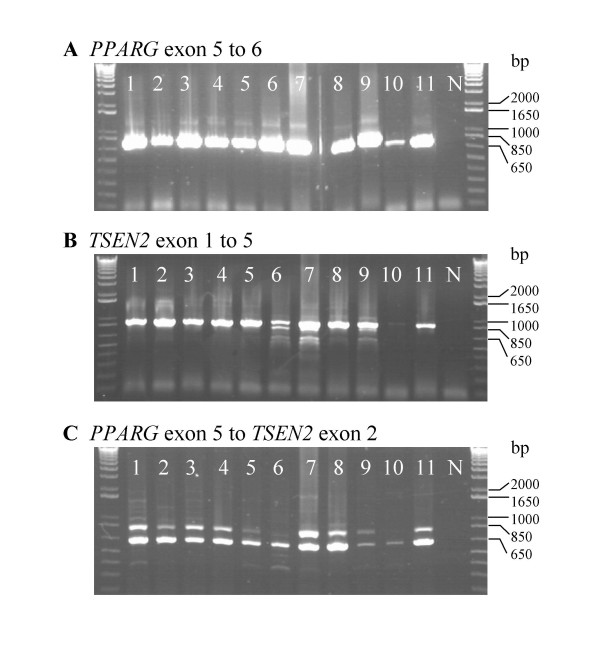
RT-PCR amplification of the PPARG and TSEN2 independent (A, B) and fusiontranscripts (C) in bovine tissues (1 to 5 skeletal muscles, 6 subcutaneous fat, 7 spleen, 8 testis,9 liver, 10 brain, 11 heart, N negative control).